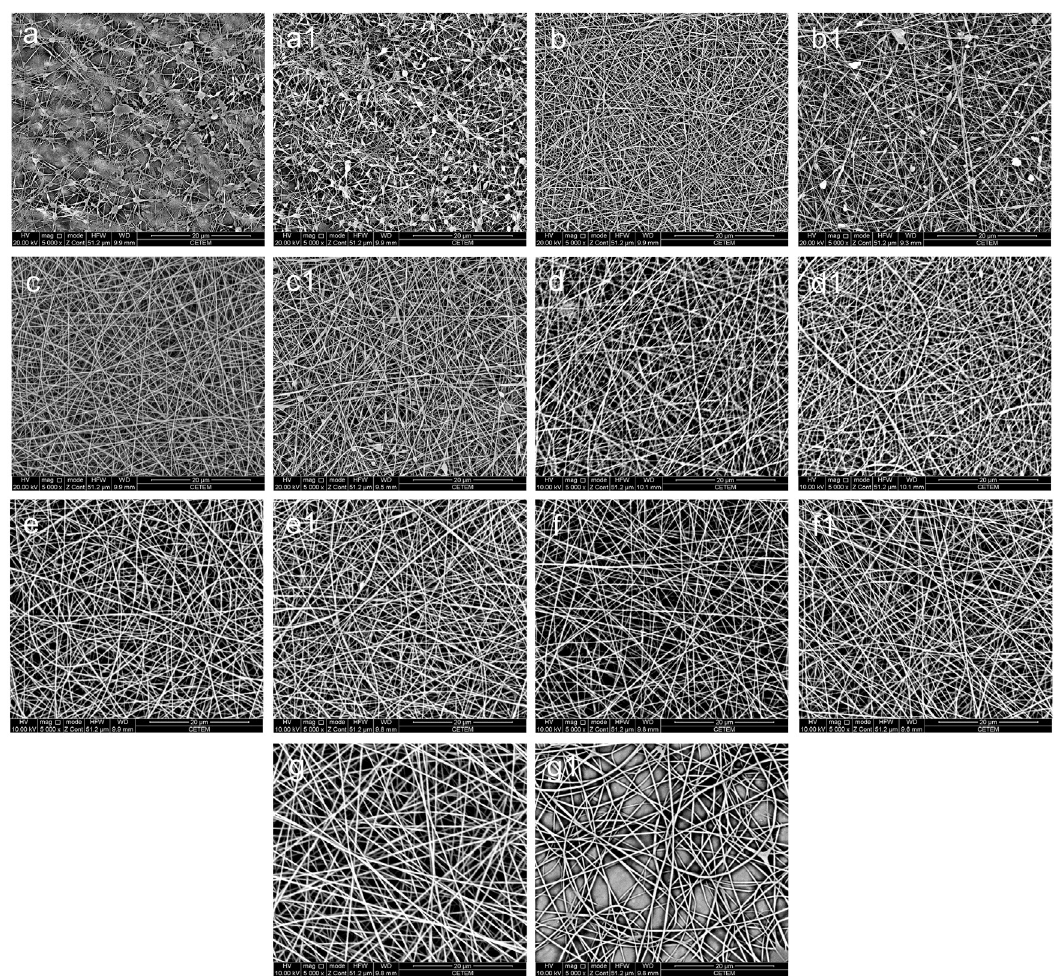
Figure 1. SEM images for PVA/CS nanofibers electrospun at 15 and 20 kV, respectively, from mixed solutions at 50:50 (mixture M1; a, a1), 60:40 (mixture M2; b, b1), 70:30 (mixture M3; c, c1), 75:25 (mixture M4; d, d1), 80:20 (mixture e, e1), 85:15 (mixture M6; f, f1), 100:0 (mixture M7; g, g1)